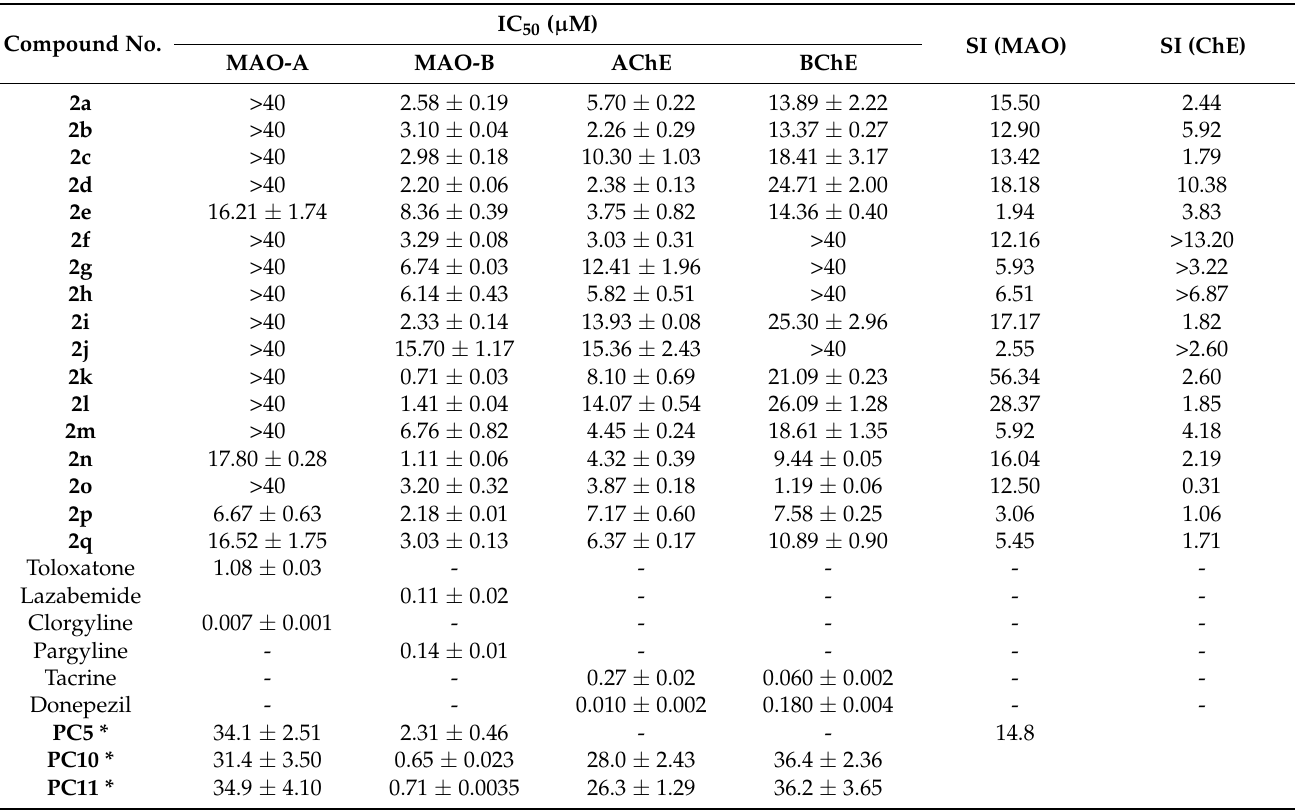
Table 2. Inhibitory activities (IC 50 , µ M) and selectivity indices of compounds 2a–q against MAO-A, MAO-B, AChE, and